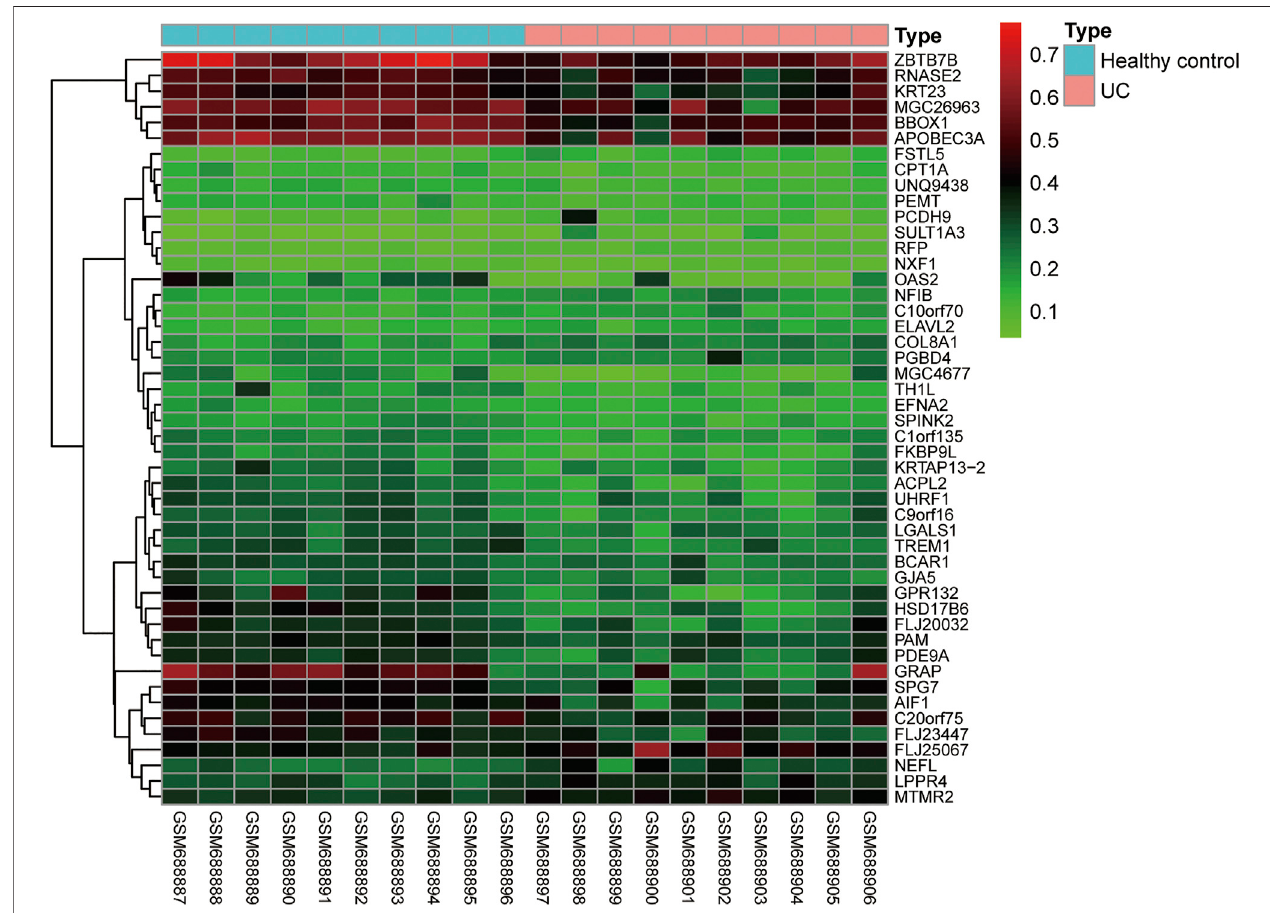
FIGURE 3 | The differently expressed DNA methylation compared UC samples with normal